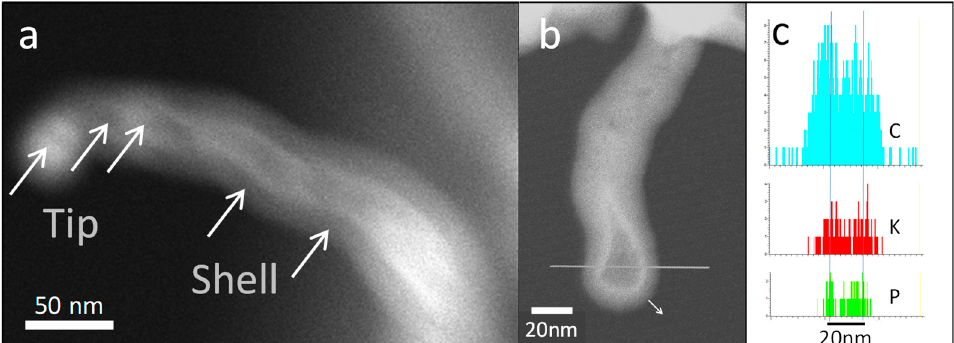
Figure 6. STEM dark field and EDX analysis of a carbon finger. ( a ) STEM dark field image, showing 3 points at tip/core (left) where EDX data was collected, and 2 points at shell (right). ( b ) STEM dark field image of structure seen in Figure 5, the small arrow indicates the small drift during the EDX acquisition; ( c ) shows the corresponding EDX line scans for C, K, and P along the line marked in ( b ). Table 1. Elemental composition (atomic%) from EDX of a finger produced by the combustion of a fresh stick of spaghetti (see Figure 6a).